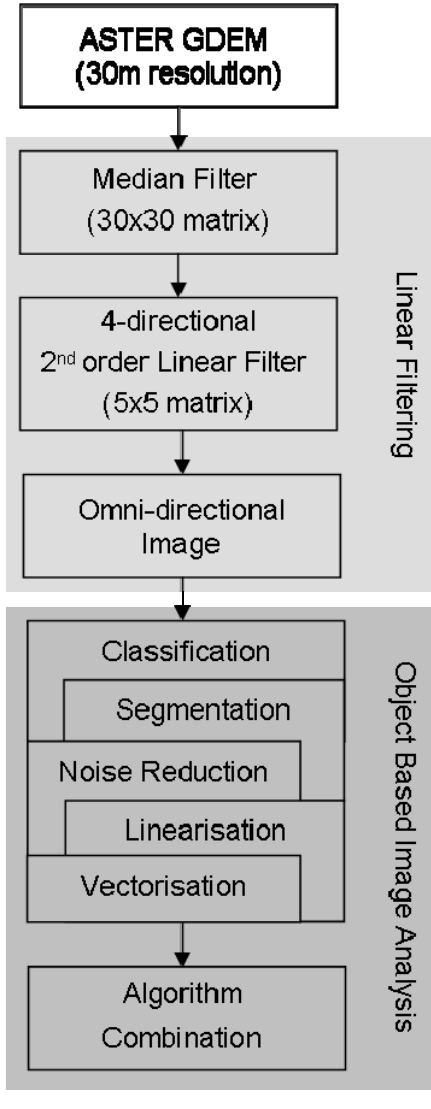
Fig. 1. Workflow of the applied methods for the semi-automatic Figure 1. Workflow of the applied methods for the semi-automatic extraction of lineaments. 2 extraction of